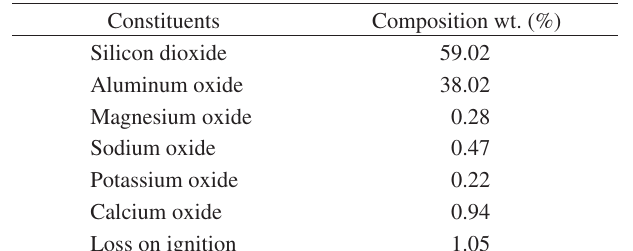
Table 3. Chemicalcompositionof Fly Ash.